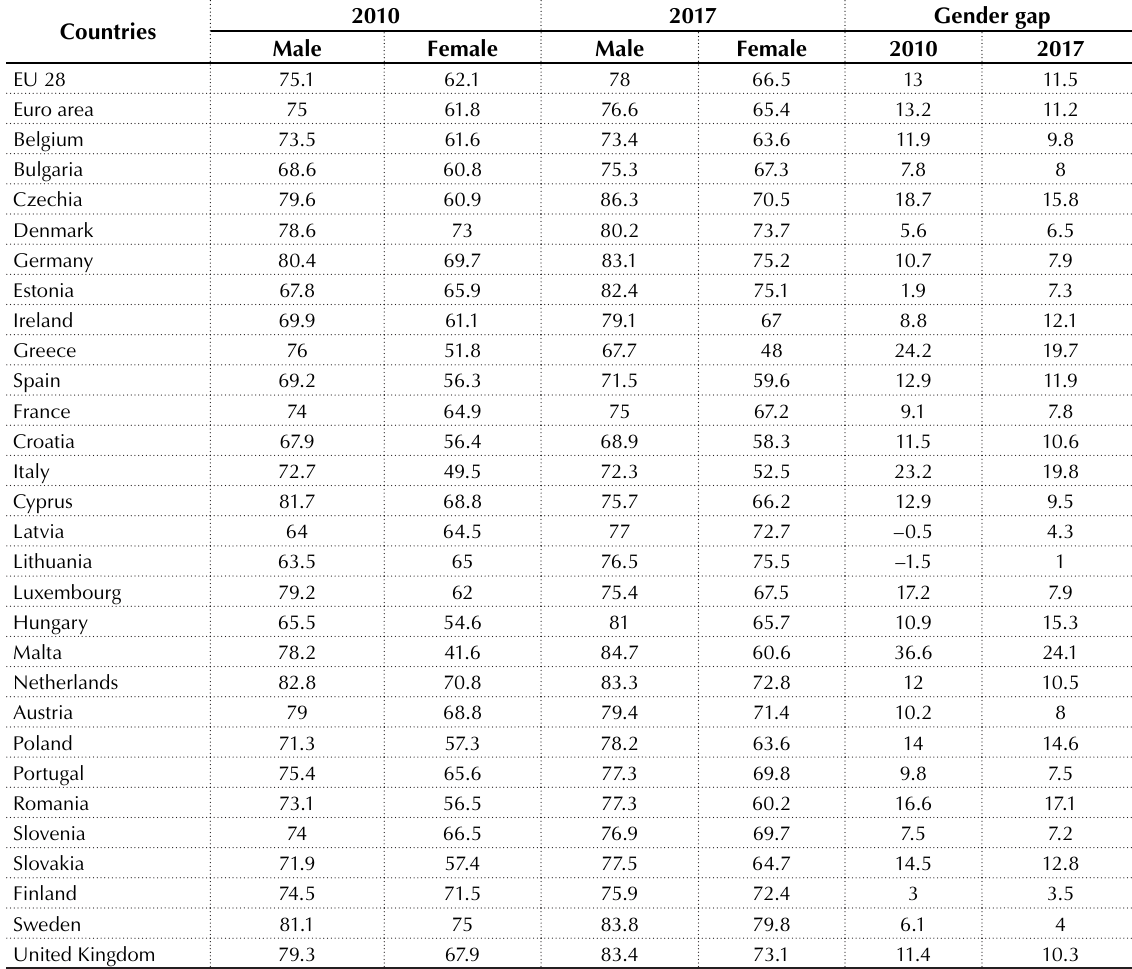
Source: Author’s calculations based on Eurostat